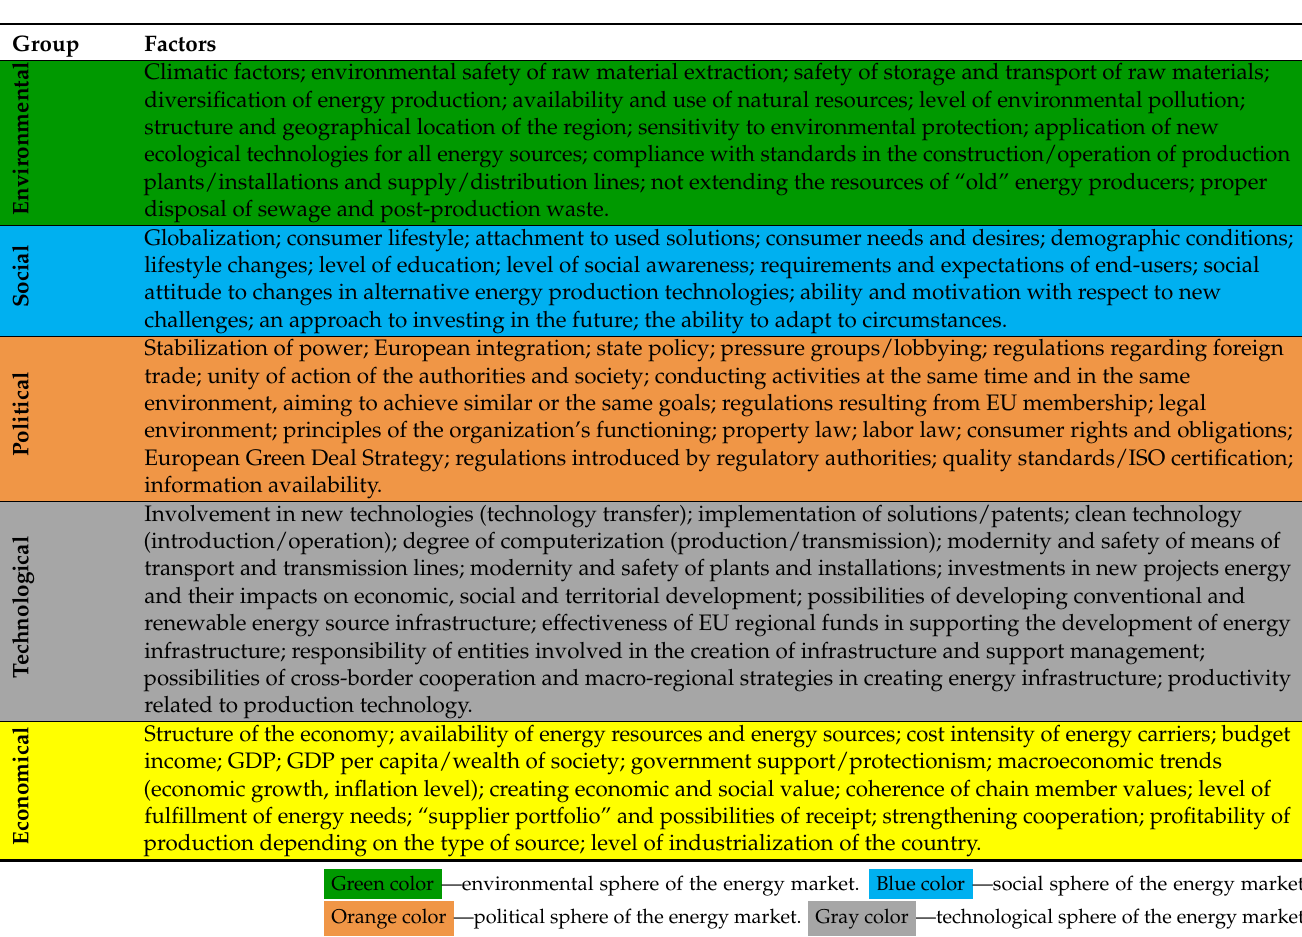
Green color —environmental sphere of the energy market. Blue color —social sphere of the energy market. Orange color —political sphere of the energy market. Gray color —technological sphere of the energy market. Yellow color —economical sphere of the energy market. Source: own study, based on: